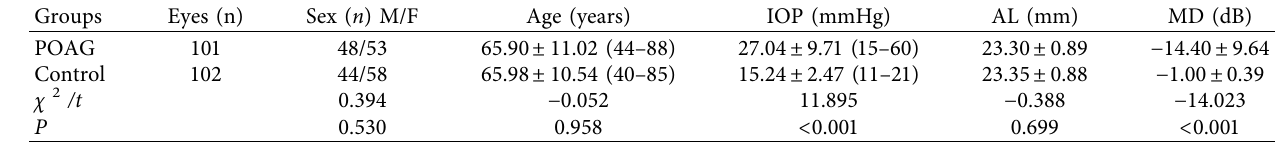
Table 1: Baseline characteristics of the study groups.